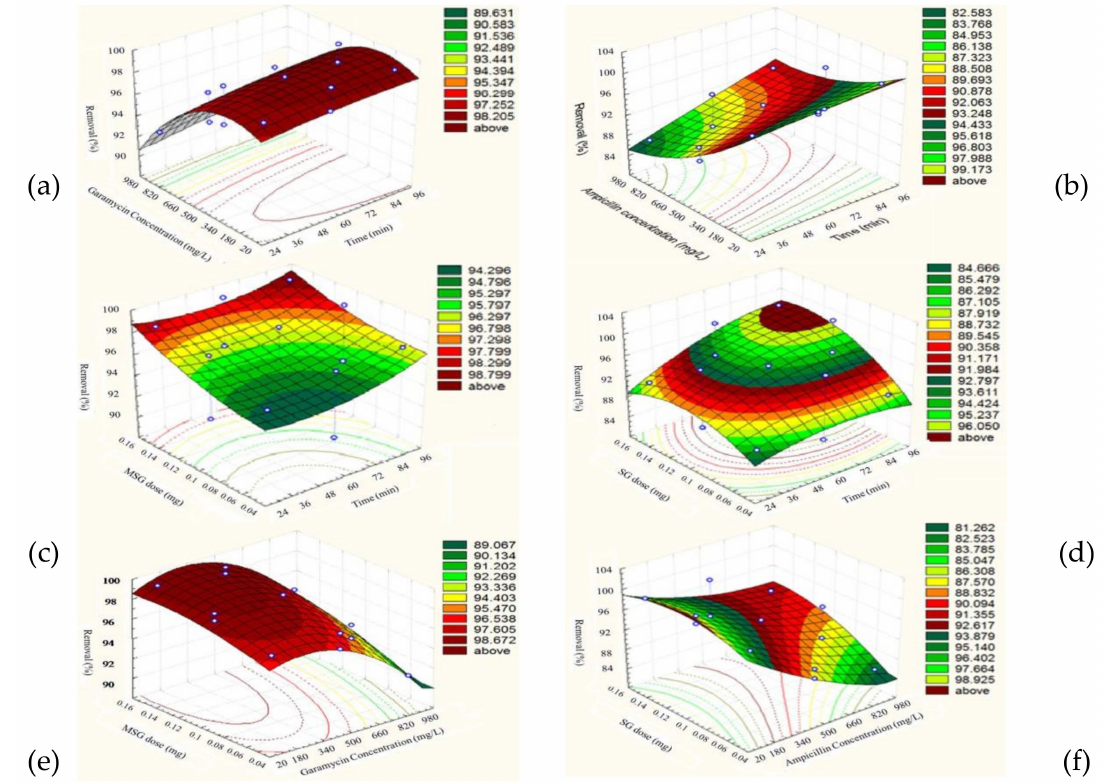
Figure 5. ( a , c , e ) represent Surface plots of response for removal e ffi ciency (%) of Garamycin on MSG, while plots ( b , d , f ) represent Surface plots of response for removal e ffi ciency (%) of Ampicillin on